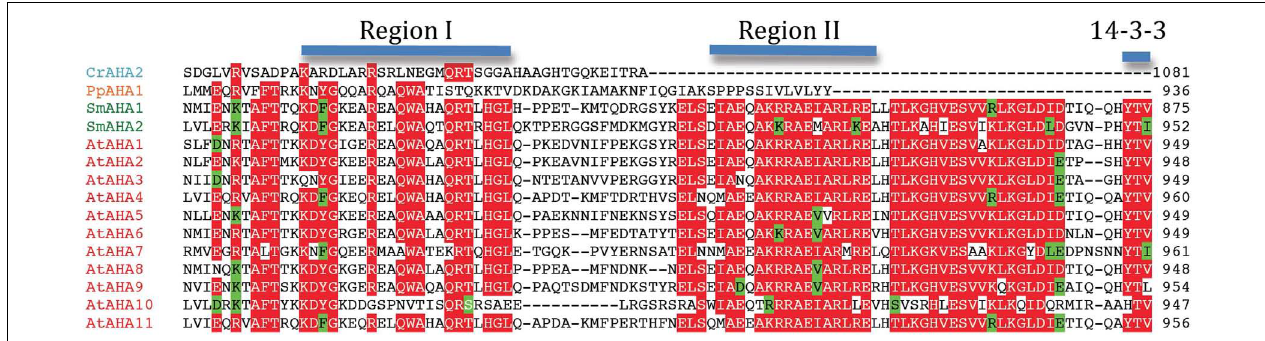
FIGURE 11 |Alignment of putative autoinhibitory regions in the C-terminal region of P3A H + -ATPases.